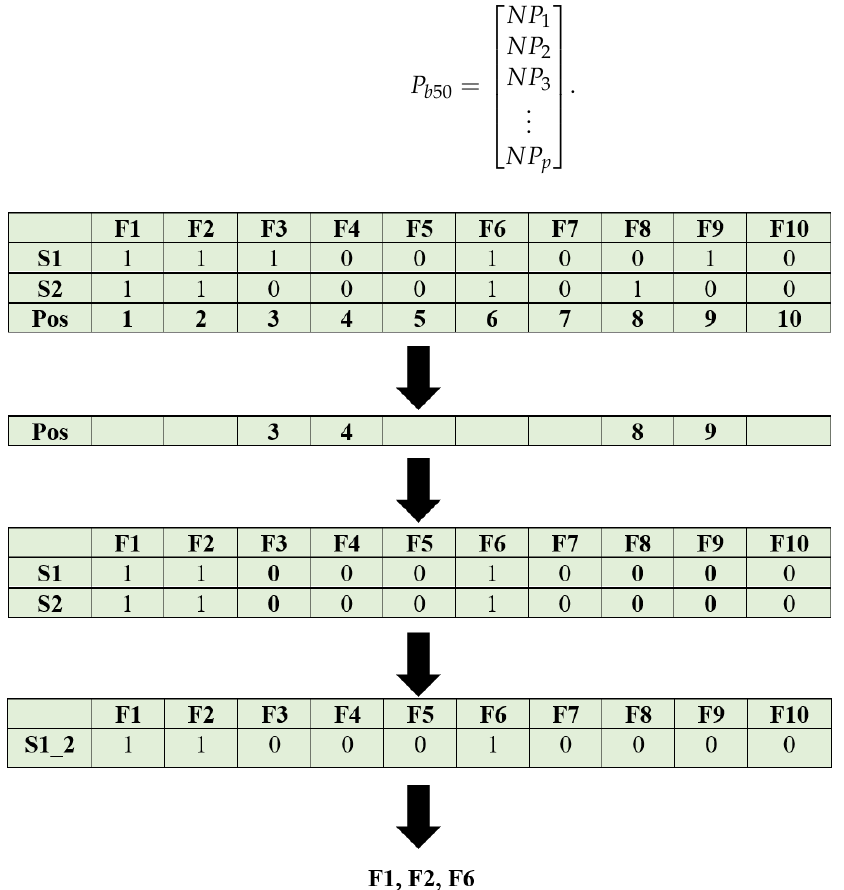
Figure 3. Illustration of proposed LPCO feature selection